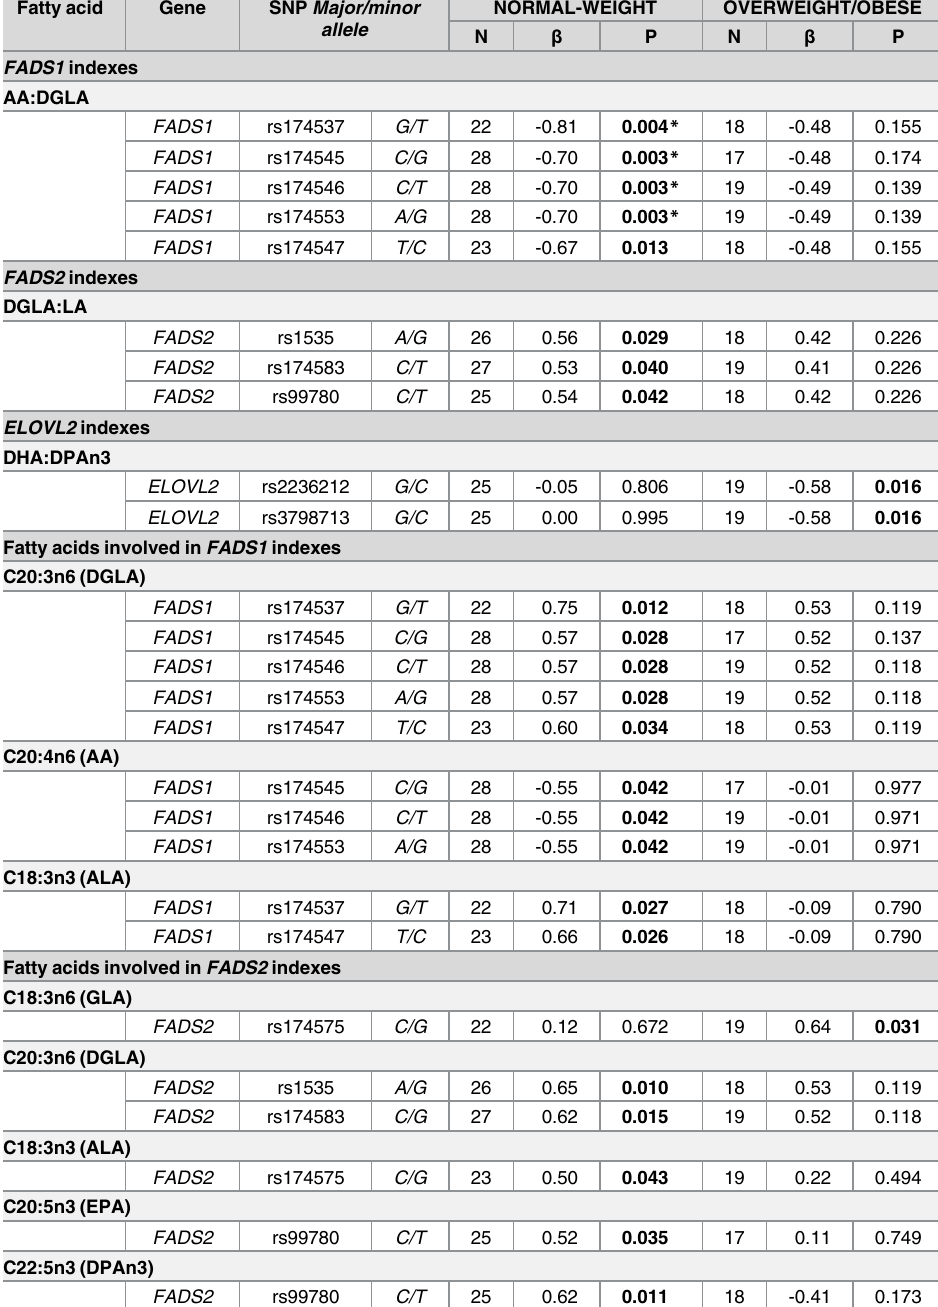
Table 2. Associations between plasma proportions of PUFAs and FADS and ELOVL